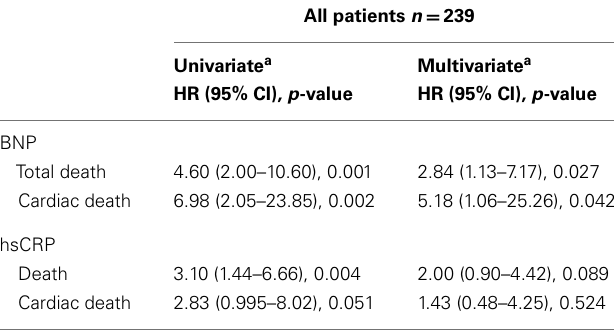
Table 3 | Univariate and multivariate analysis